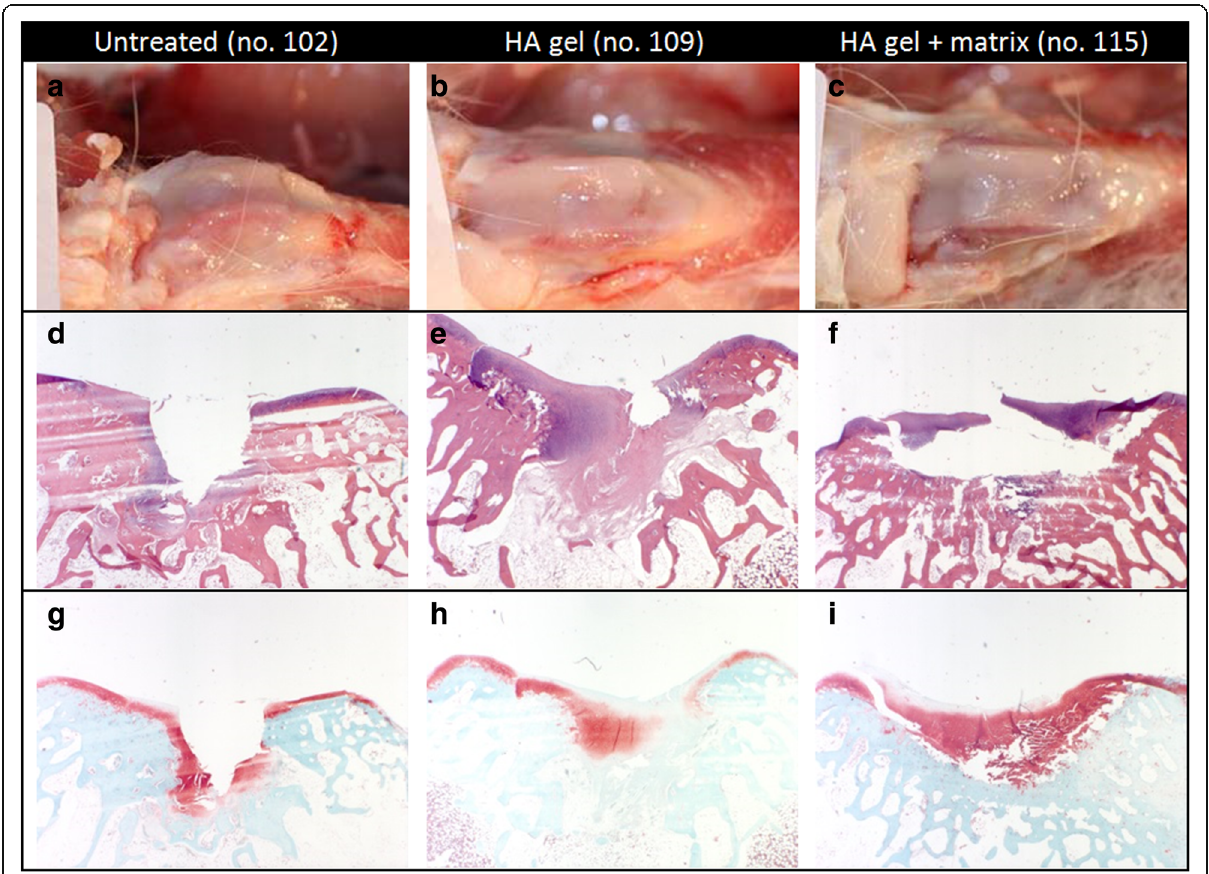
Fig. 3 Gross morphology and histology of one representative rabbit per group sacrificed 12 weeks after treatment. a – c shows the implantation site of the trochlea of the femur. d – f represents cross-section histology of the implantation site stained with hematoxylin and eosin (H & E). In the untreated group ( d ) the defect was observed with little tissue formation, while the HA gel ( e ) or HA gel + matrix ( f ) enhanced better repair tissue with adequate cell distribution ( violet ). g – i shows cross-section histology of the implantation site stained with safranin-O. In the untreated group ( g ) a high proteoglycan staining ( red ) was detected in the almost existing defect. The HA gel group ( h ) shows more proteoglycan staining, but not as much observed in the group treated with HA gel + matrix ( i